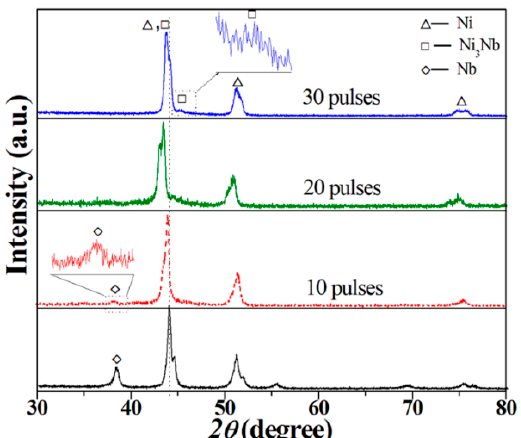
Figure 3. XRD pattern of the initial Ni-Nb coating and after HCPEB irradiation.